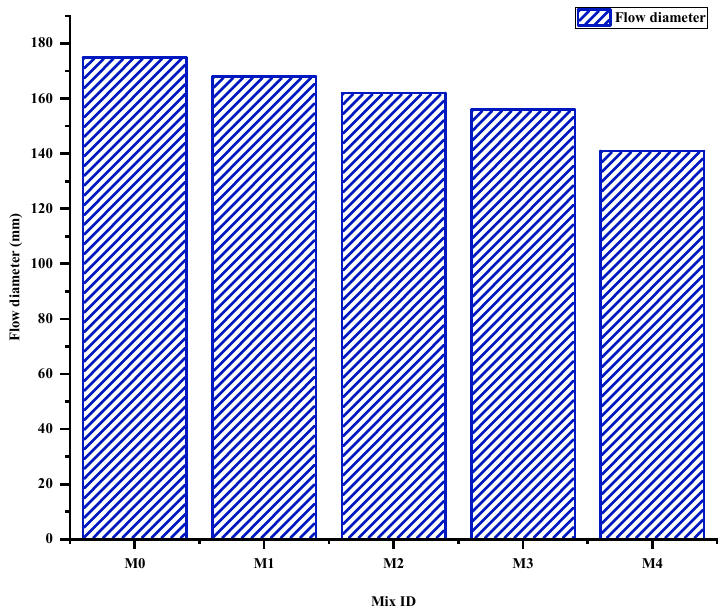
Figure 1. Flow diameter of BFRFGC for five different mixes .